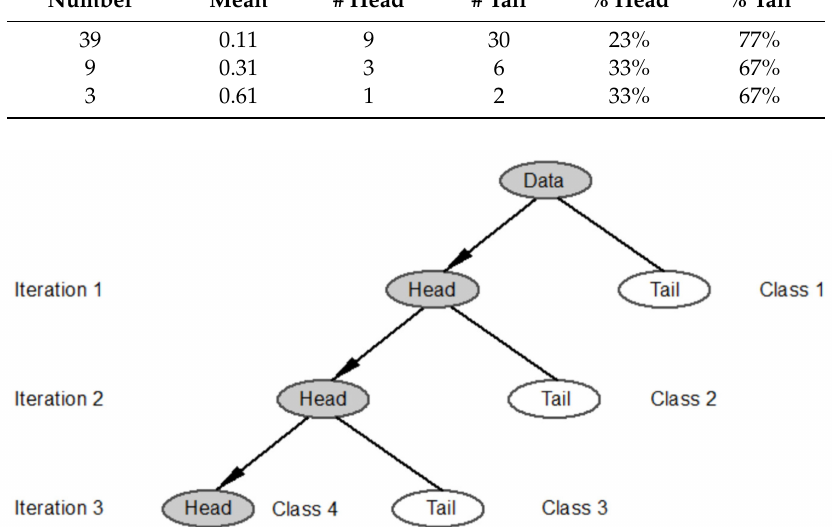
Figure 3. Illustration of the head / tail breaks as an iterative function. (Note: The data as a whole is recursively divided into the head (for those greater than the average) and the tail (for those less than the average). The whole or data is seen as an iterated system, i.e., the head of the head of the head and so on. For the sake of simplicity, we illustrate three iterations or four